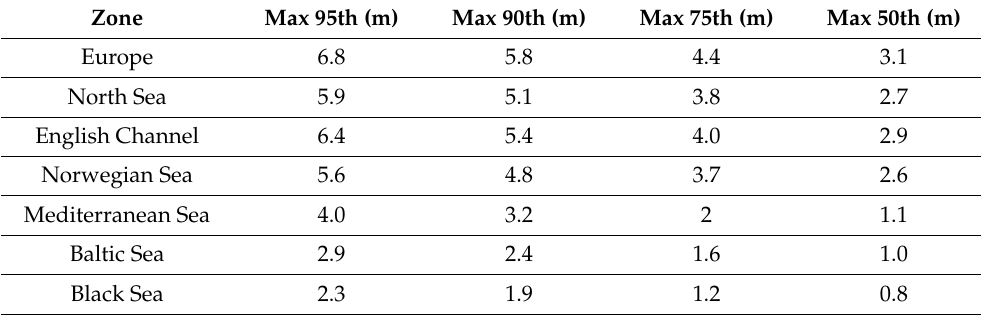
Table 4. Maximum values of percentiles computed for Hs in each area considered.